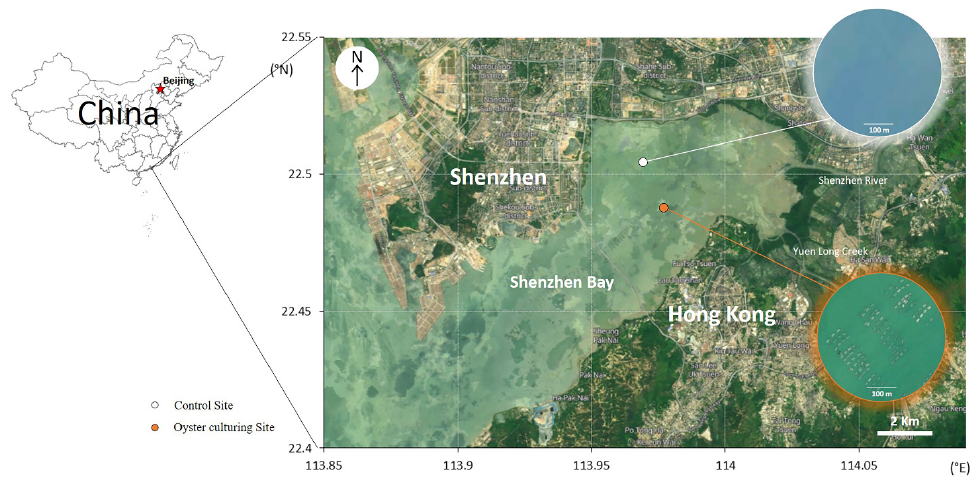
Figure 1. Location of the sampling sites. More detailed satellite images are inset on the right-hand side to show that there are many oyster-culturing rafts at the oyster-culturing site and no oysters being cultured at the control–non-oyster-culture site.